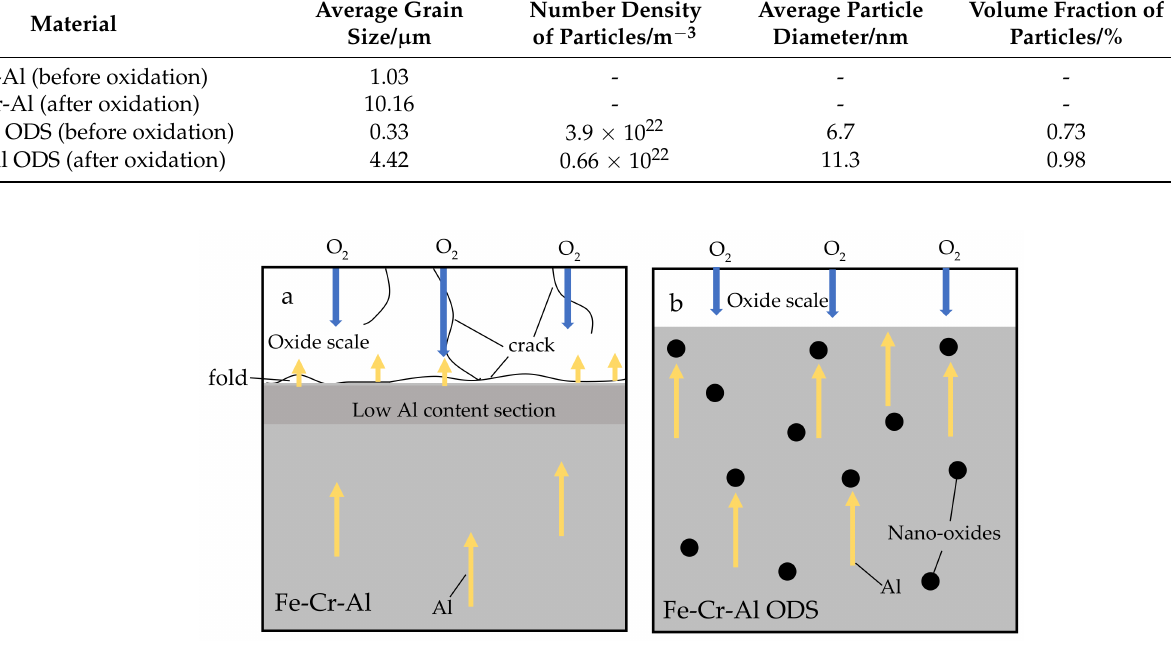
Figure 8. Schematic illustration of mechanism of high-temperature oxidation: ( a ) Fe-Cr-Al alloy and ( b ) Fe-Cr-Al ODS